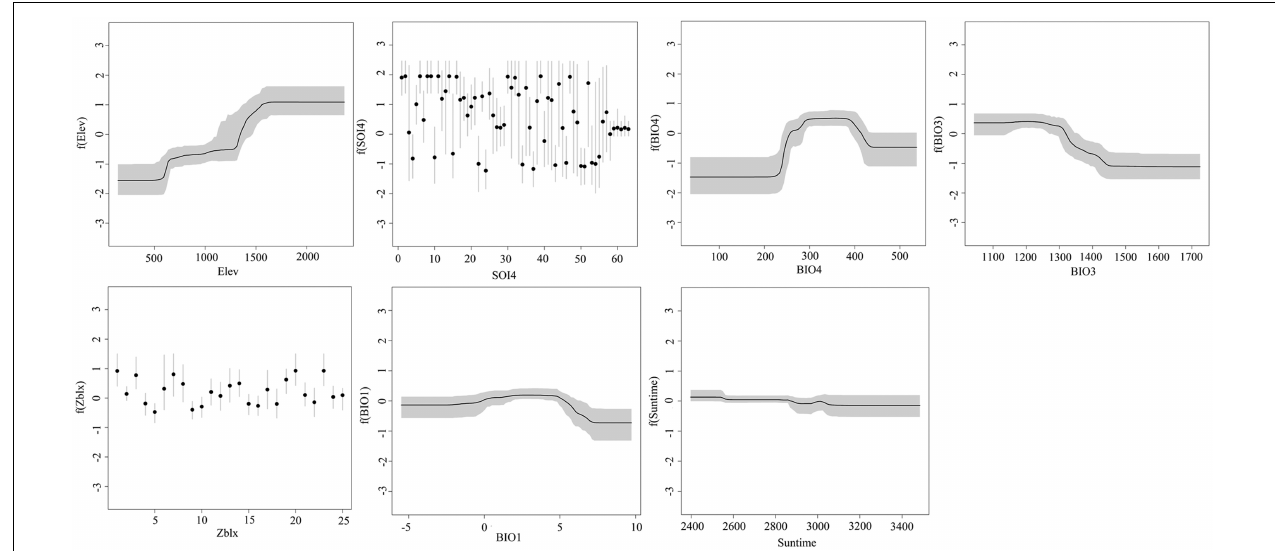
FIGURE 3 | The marginal effect curves of the main spatial predictors (RC > 2.00%) over all 200 BRT ensemble models (The meaning of the numbering in SOI4 and Zblx is given in Supplementary Tables 3, 4 ).